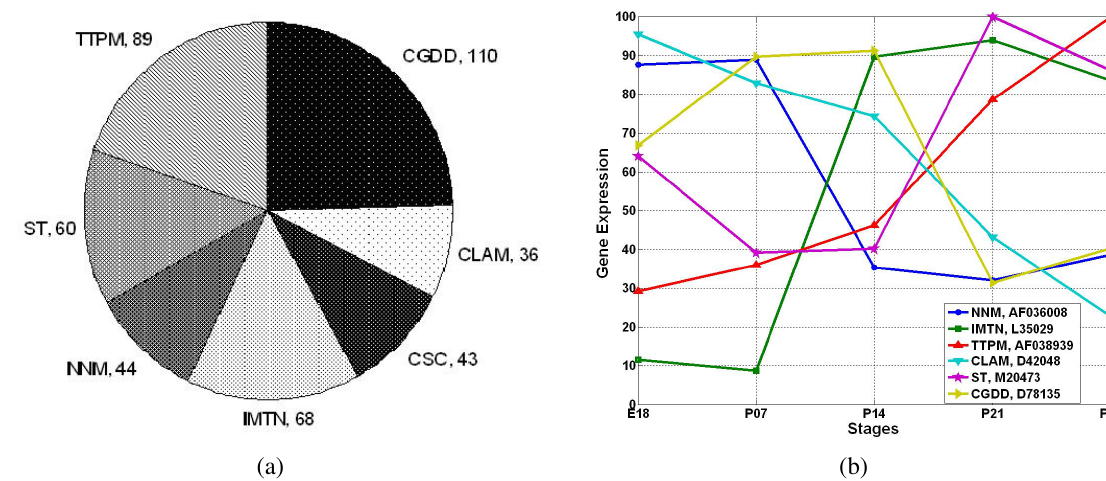
Figure 9: (a) Profile of the genes in 7 function groups, (b) the first 6 distinct genes which belong to the 6 function groups